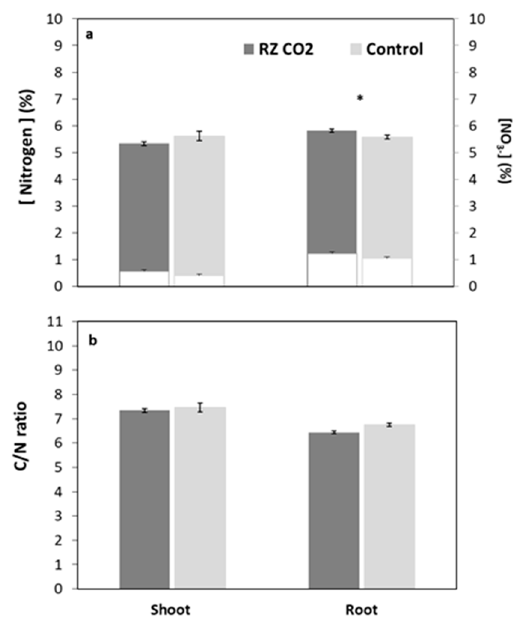
Figure 3. Shoot and root N and NO 3 − concentration ( a ) and C / N ratio ( b ) in lettuce plants exposed to high and ambient RZ CO 2 . Experiment 7. Bars are means ± SE of 8 replicates. White bars indicate NO 3 − concentration levels. Asterisks indicate significant di ff erences between treatments (Independent Sample T-test, p -value < 0.05). Table 7. Lettuce shoot and root nutrient content under elevated RZ CO 2 and control plants. Experiment 7. Di ff erent letters and bold text indicate significant di ff erences between treatments ( p < 0.05).